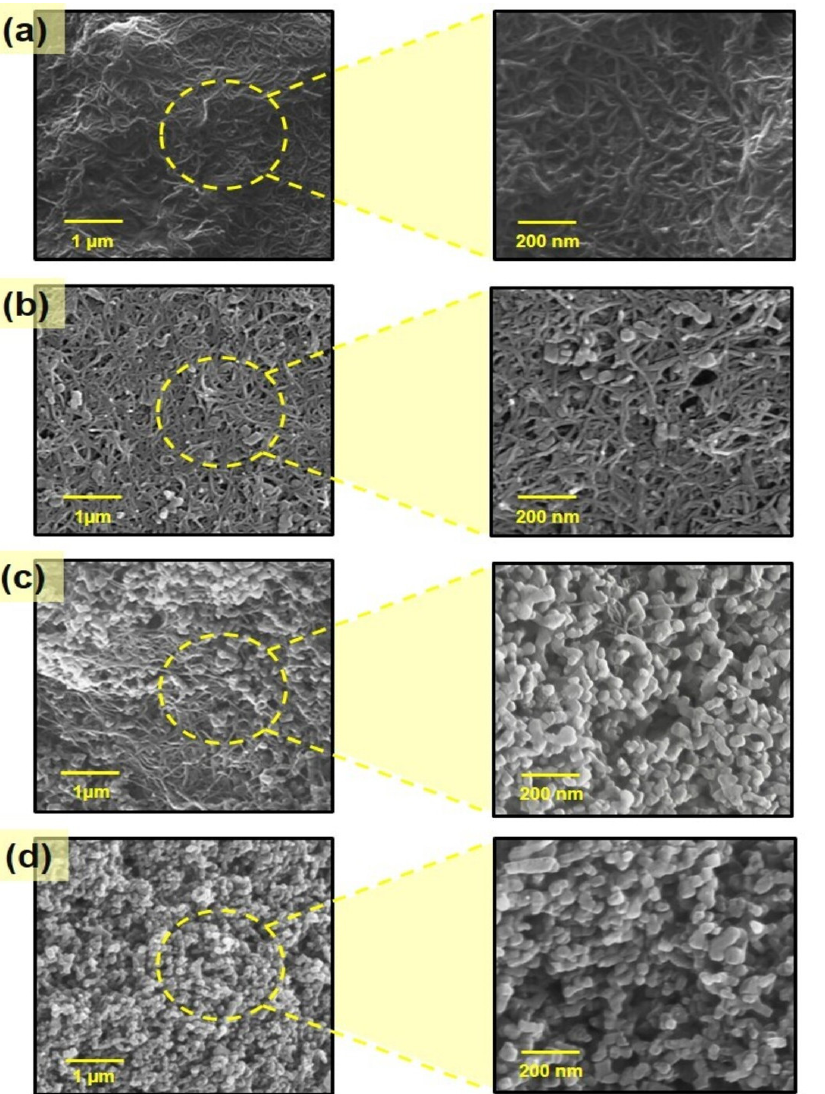
Figure 4. SEM micrographs of the following: ( a ) CHI–CNT, ( b ) CHI–CNT@PB, ( c ) CNT–PB, ( d ) CHI–PB.